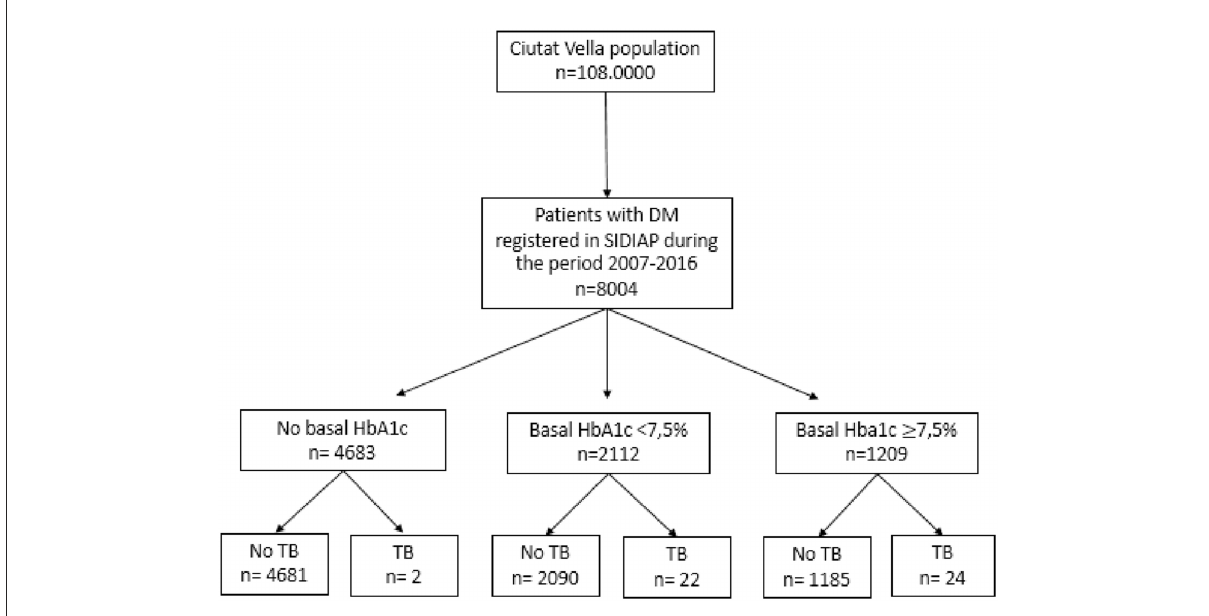
FIGURE1 Flow chart of the DM cohort within the study population.